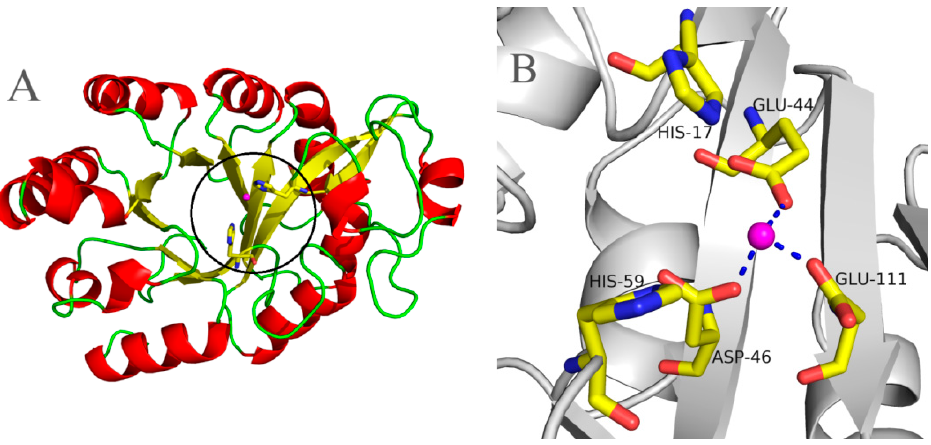
Figure 8. Molecular 3D model of pfGDPD and locations of the deduced catalytic sites. ( A ) the 3D model of pfGDPD protein was built with a SWISS-MODEL Web Server (Basel, Switzerland) by using the crystal structure of Thermococcus kodakarensis KOD1 GDPD (PDB: 4OEC) as template. The colored segments of the backbone structure mark the location of α helix (red), β sheet (yellow) and loop (green). The black circle shows the active region; ( B ) the active site of two histidine residues are shown as a stick. A bivalent cation is shown in magenta, and broken blue lines represent the hydrogen bonds that form with Glu44, Asp46 and Glu111 residues.